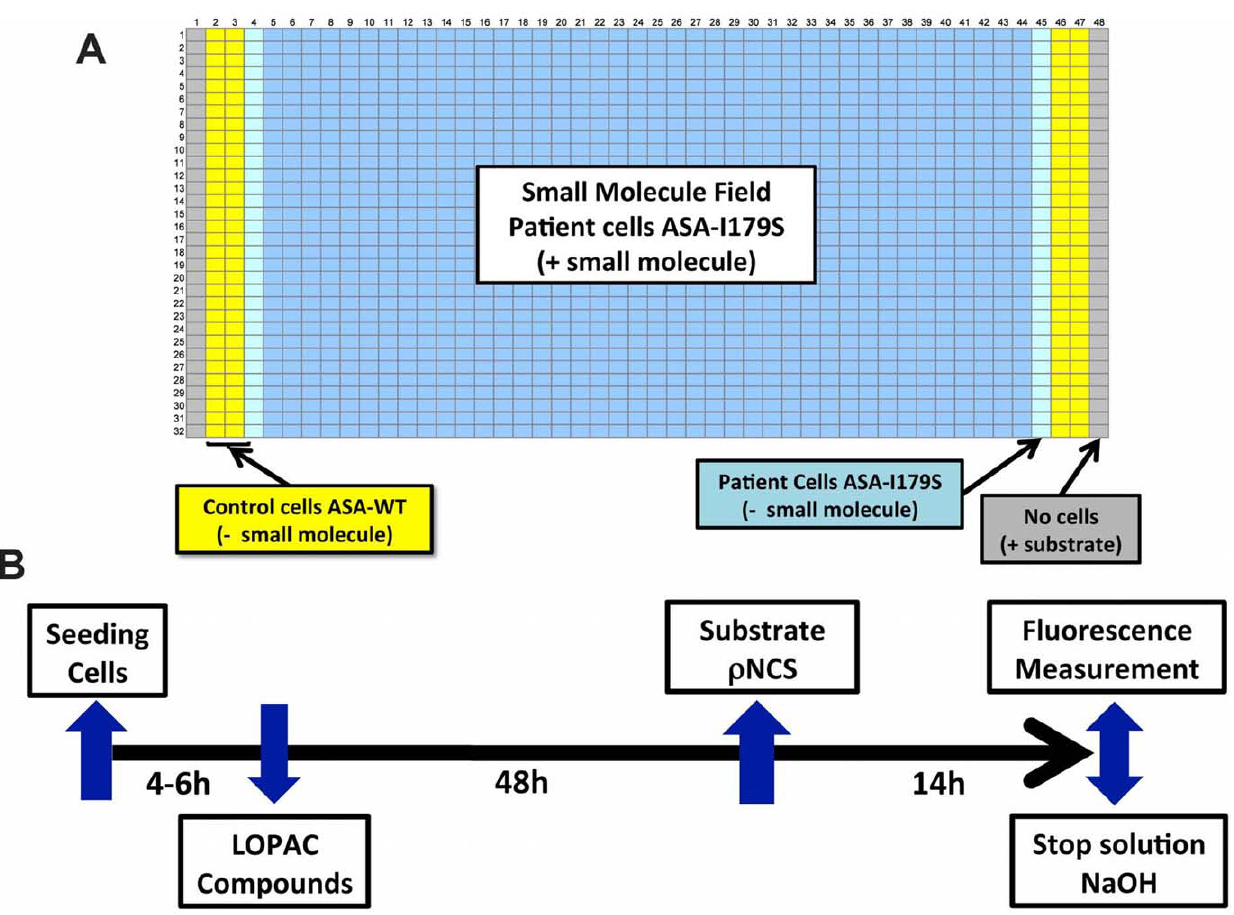
Figure 5. The design of a cell-based HTS assay for ASA in 1,536-well plates. ( A ) The disposition of SV40t fibroblasts from MLD patient (ASA- I179S - blue) and from control (ASA-WT - yellow) in a 1,536-well plate. ( B ) The time-line of events of this cell-based HTS assay for ASA. A library of 1,280 small-molecules at seven different concentrations from 7 6 10 2 3 to 114.2 microM was used to perform a pilot HTS assay. A total of eight 1,536- well plates in the same format were assayed including one plate with cells treated with DMSO (solvent of compounds) and seven other plates for each of the LOPAC concentration tested.